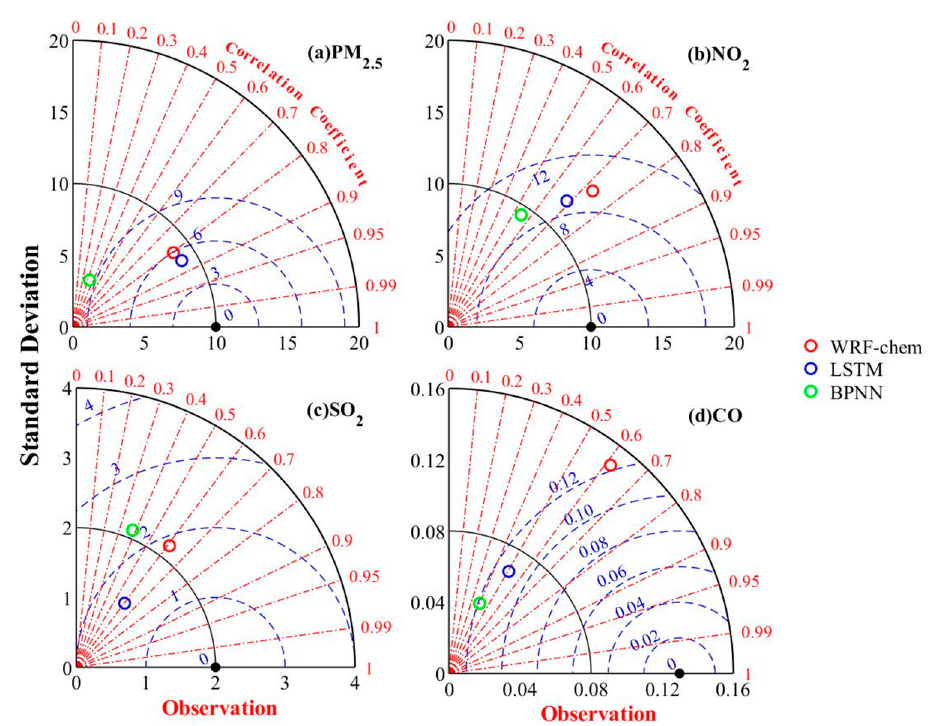
Figure 11. Taylor plots for the different pollutant concentrations according to the observations and